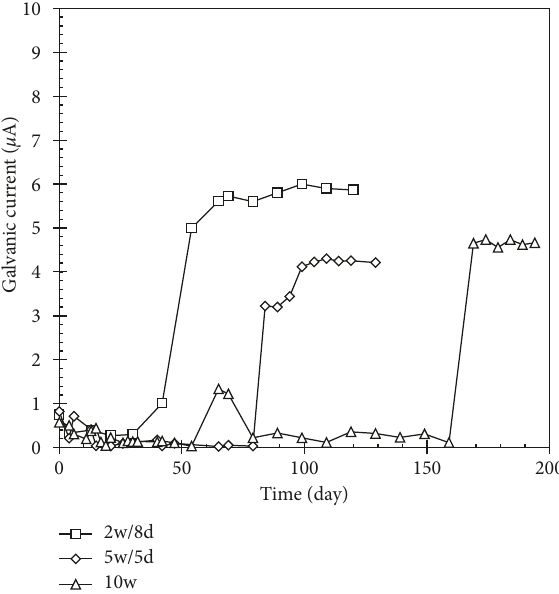
Figure 2: Galvanic current monitoring with different wet time